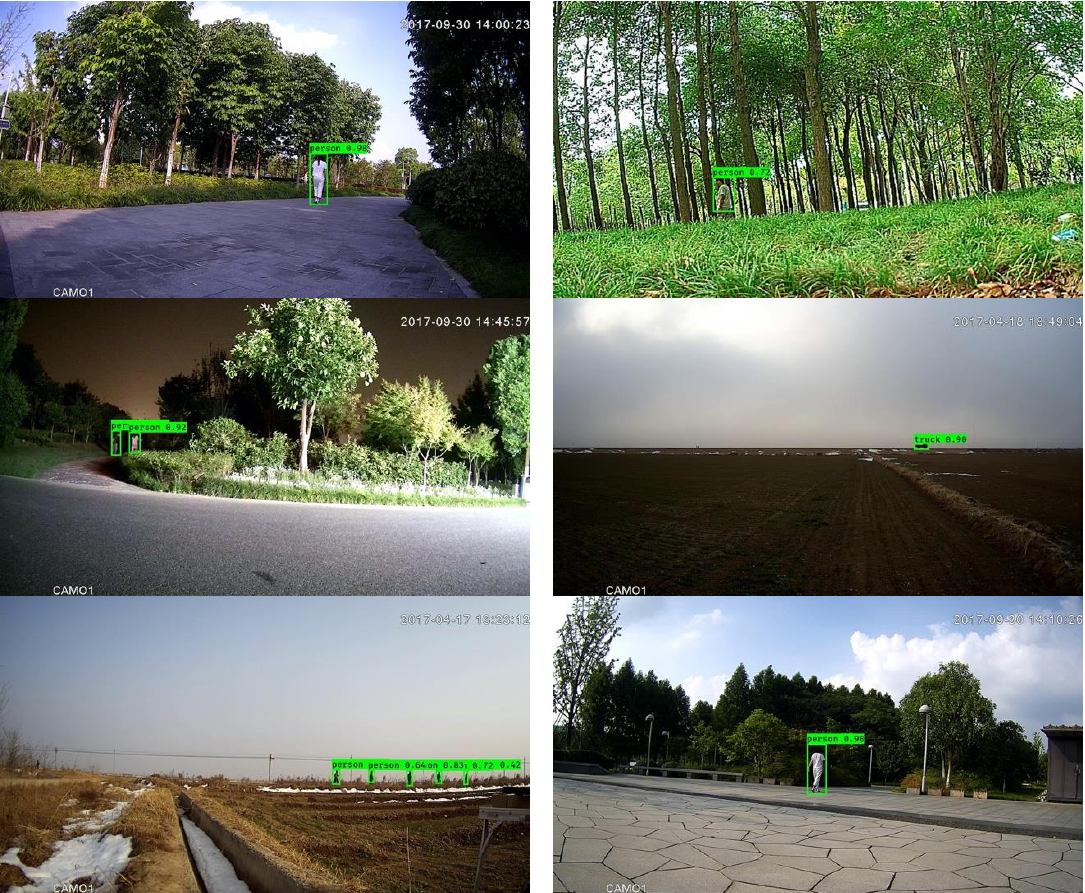
Figure 9. Outcomes of the entire framework.